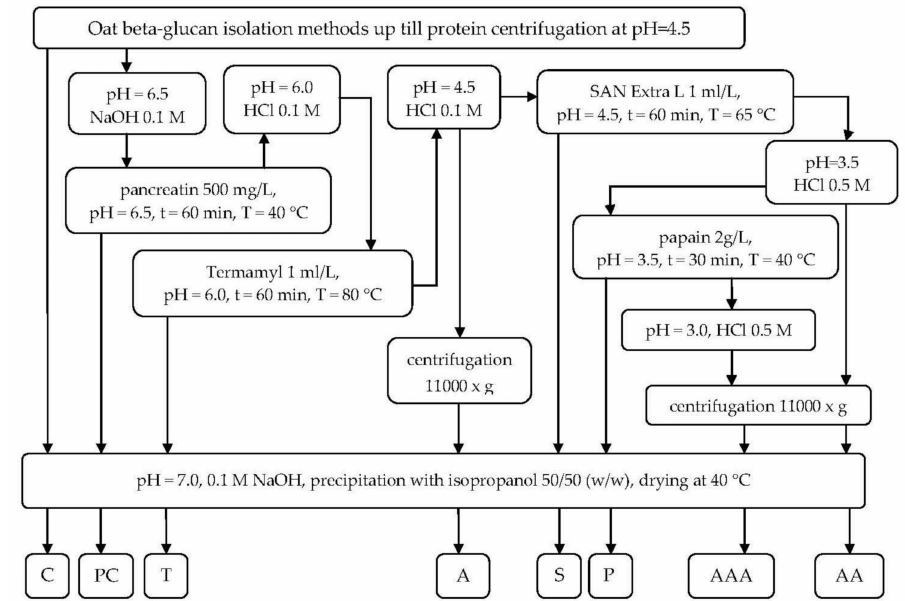
Figure 1. β -Glucan purification block-flow diagram. C—control sample, PC—sample after